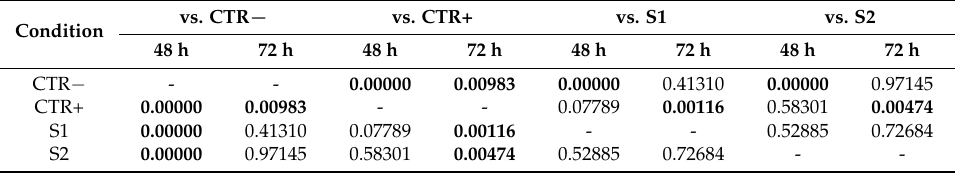
Table 3. ANOVA and Tukey-Kramer test statistical analysis of cell viability (MTT test) of the conditions CTR − , CTR+, S1 and S2 at 48 and 72 h (statistically significant values in bold, p < 0.05). vs. CTR − vs. CTR+ Condition